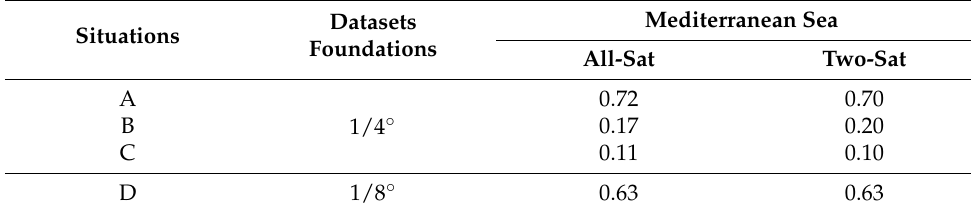
Table 4. Probabilities of eddy matching in the Mediterranean Sea. Situations